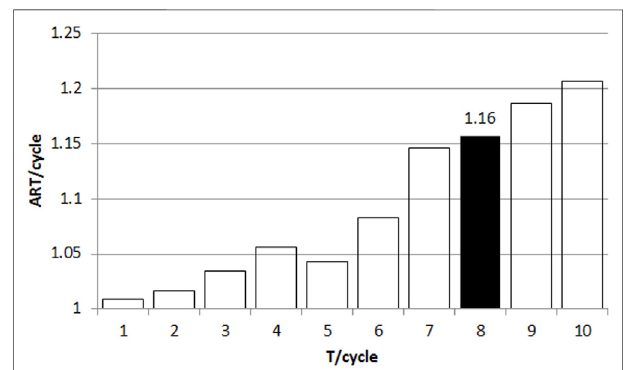
FIGURE 8 | T on the relationship of ART .